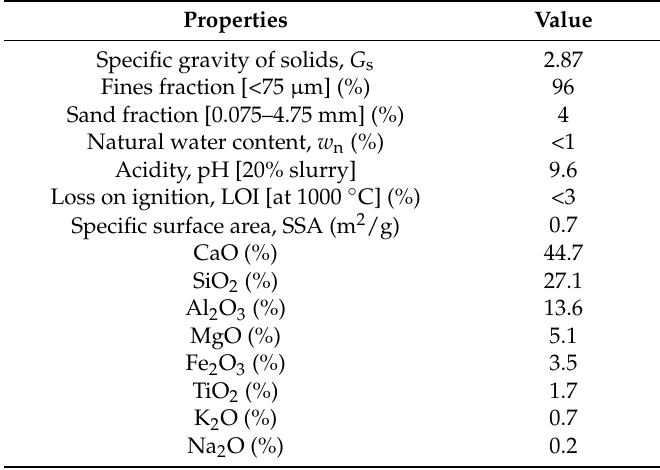
Table 4. Physical properties and chemical composition of GBFS (as supplied by the